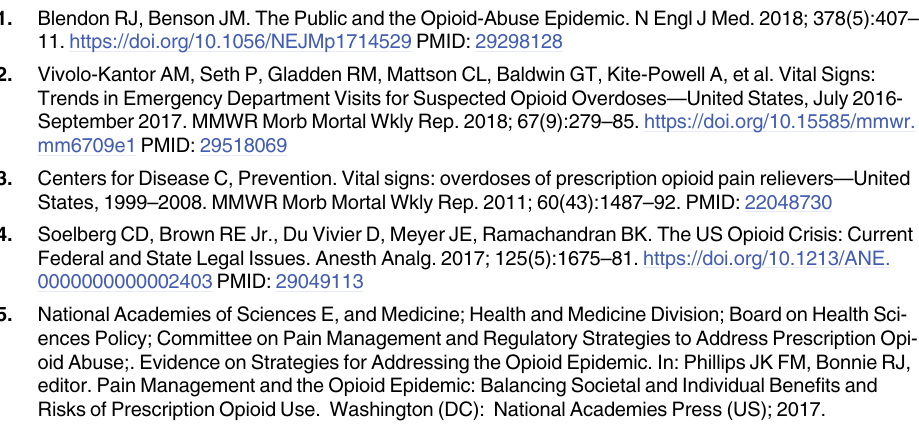
S1 Table. Trajectory model parameters from the final